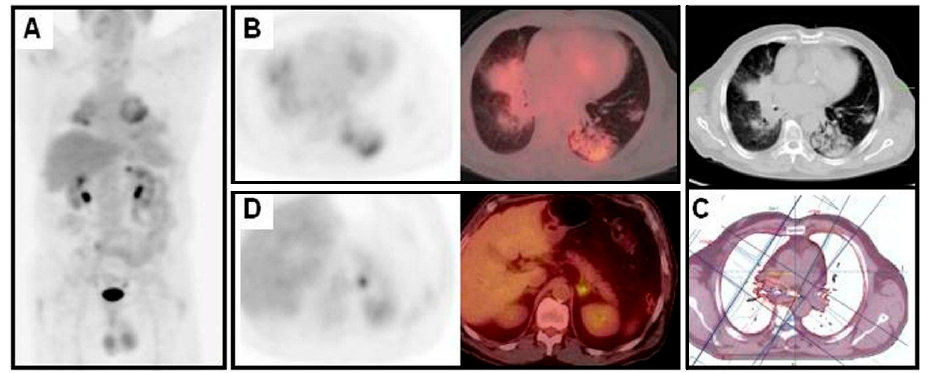
Figure 1. Patient with an adenocarcinoma near the right hilum treated with chemo-radiotherapy. A follow up CT performed four months later showed non-conclusive radiological lung findings. An 18 F-FDG PET/CT showed increased lung uptake related to the radiotherapy area ( A – C ). Also, focal hypermetabolism in left adrenal gland was detected ( D ). Surgery confirmed an adrenal metastasis.